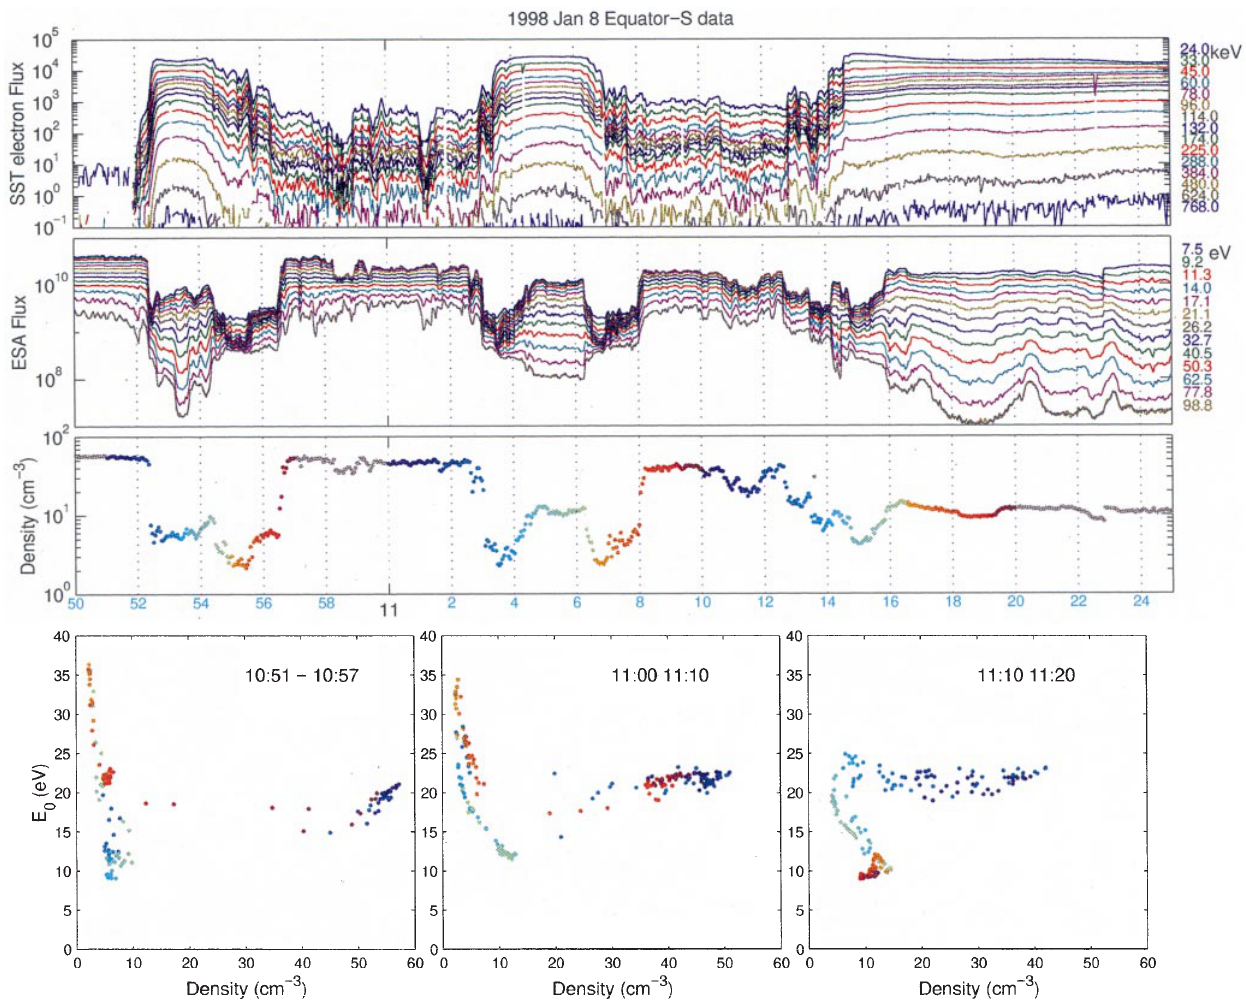
Fig. 6. As for Fig. 3, except here the density curve has been color coded so that the data shown in the three panels below can be followed in time. The behavior shown characterize the three intervals when the spacecraft was in the